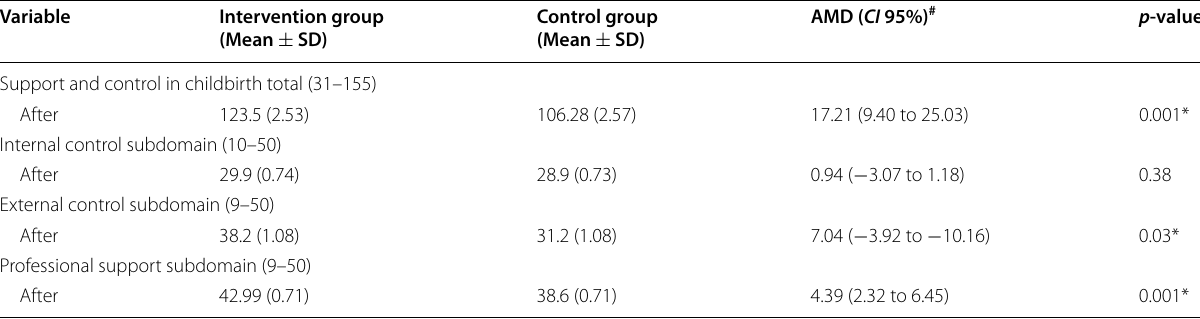
# ANCOVA test with control of baseline values. # Mean difference with confidence interval of 95%. *Significant at p <0.05